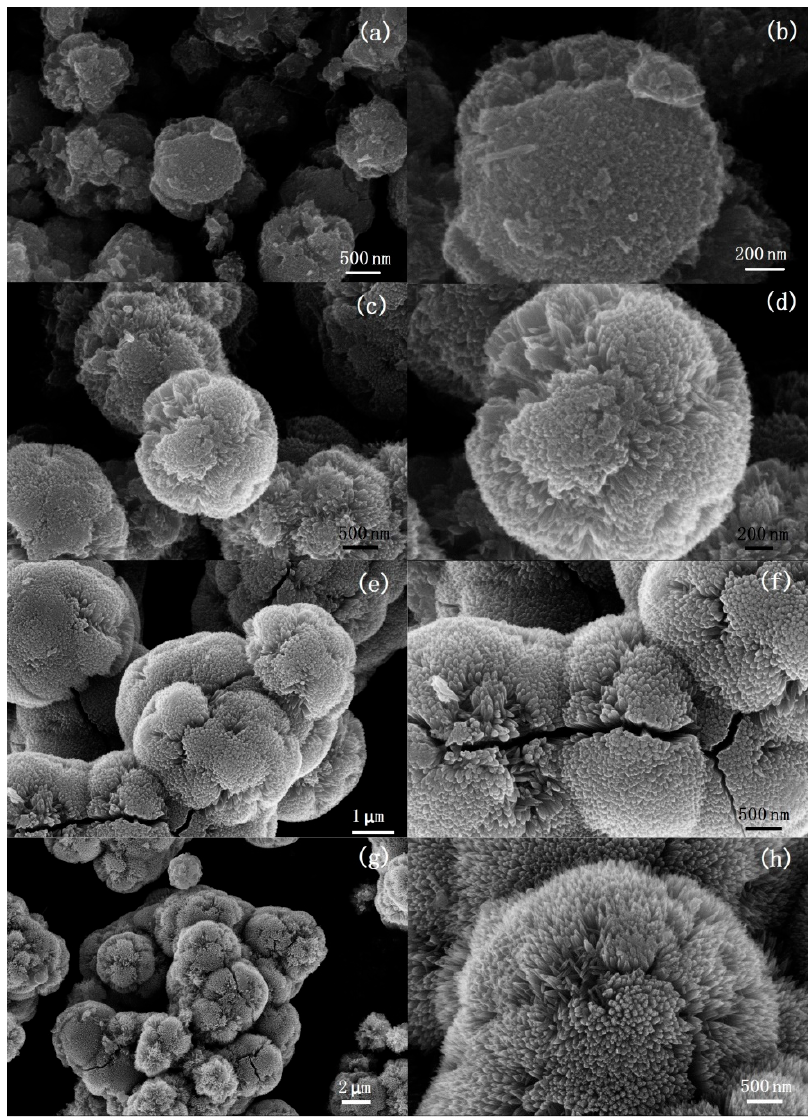
Figure 5. SEM images of TiO 2 samples synthesized at the different volume ratio of TiCl 4 solution to toluene. ( a , b ) 1:30; ( c , d ) 1:15; ( e , f ) 1:10; ( g , h ) 1:7.5.